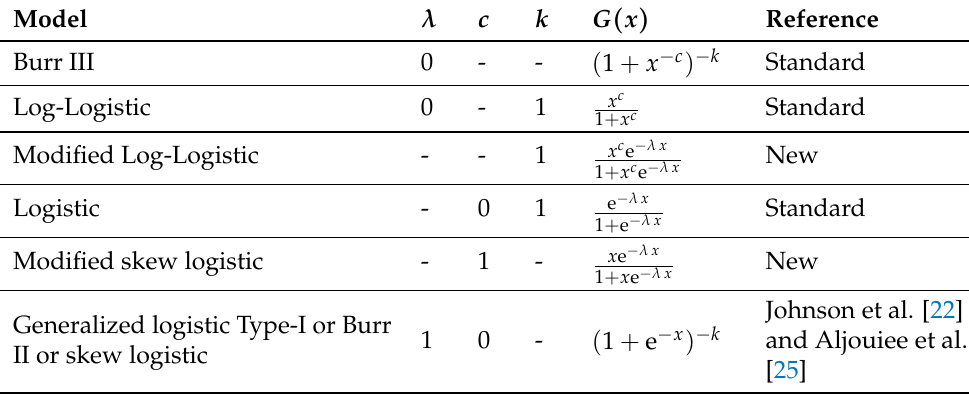
Figure 2. Hazard function for NMBIII distribution. Figure 1 represents the different shapes of the proposed model, i.e., bimodal, reversed- J, right skewed, approximate left-skewed, and symmetrical shapes for different parameter values. Figure 2 reflects the different shapes of hazard function, which are increasing, de- creasing, bathtub, upside-down bathtub, and nearly constant for different parameter values. The proposed distribution is more flexible and tractable than its parent BIII distribution, as well as MBIII distributions (see in Table 1). Table 1. Sub models of NMBIII